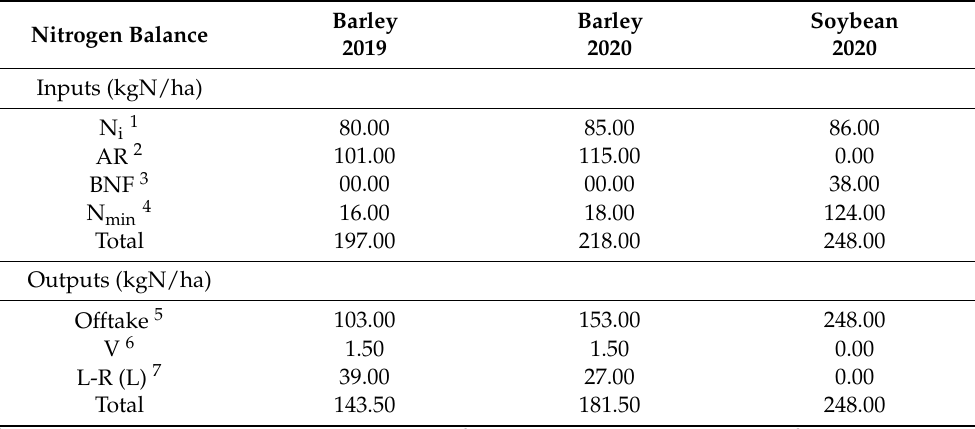
Table 3. Nitrogen balance in barley and soybean crops located in Tandil County, Buenos Aires province, Argentine Pampas Region, 2019 and